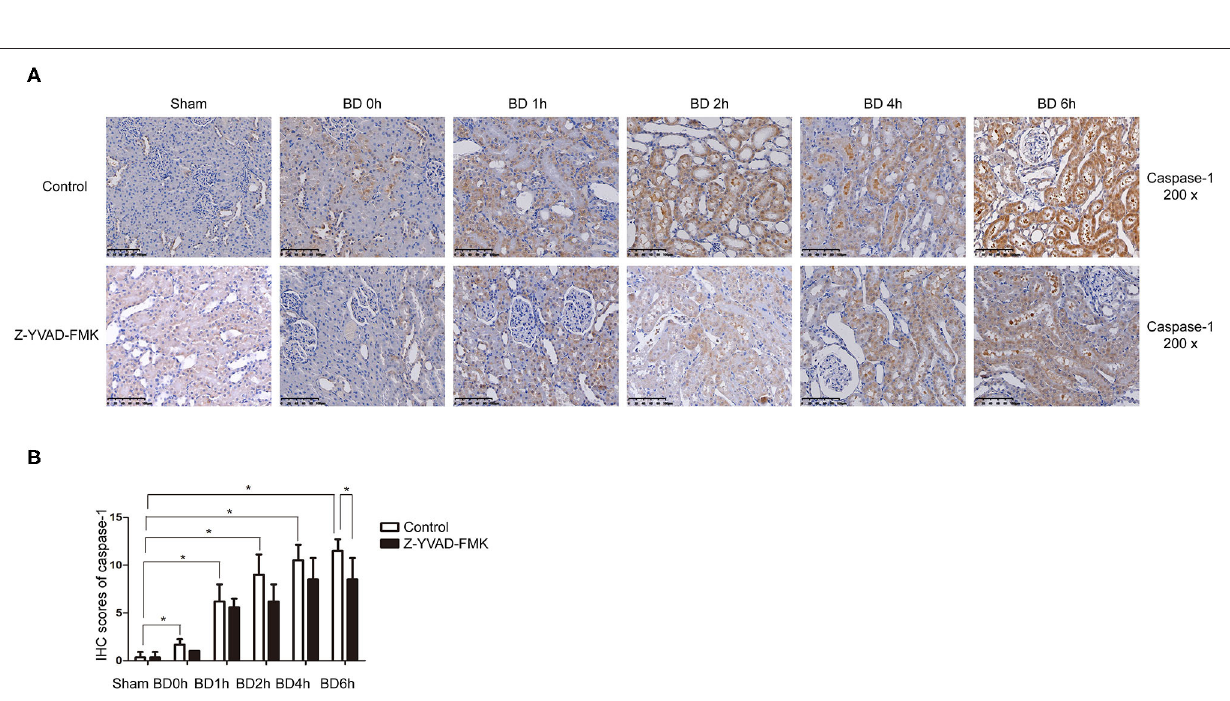
FIGURE 2 | Immunohistochemical (IHC) score of caspase-1 in control cohort and Z-YVAD-FMK-treated cohort. There were sham, BD 0, 1, 2, 4, and 6h group ( n = 6 in each group) in each cohort. (Magnification 200 × ). (A) Control cohort and Z-YVAD-FMK-treated cohort. (B) IHC score of caspase-1 in different cohorts. * p < 0.05. BD = brain-death; Sham = without brain